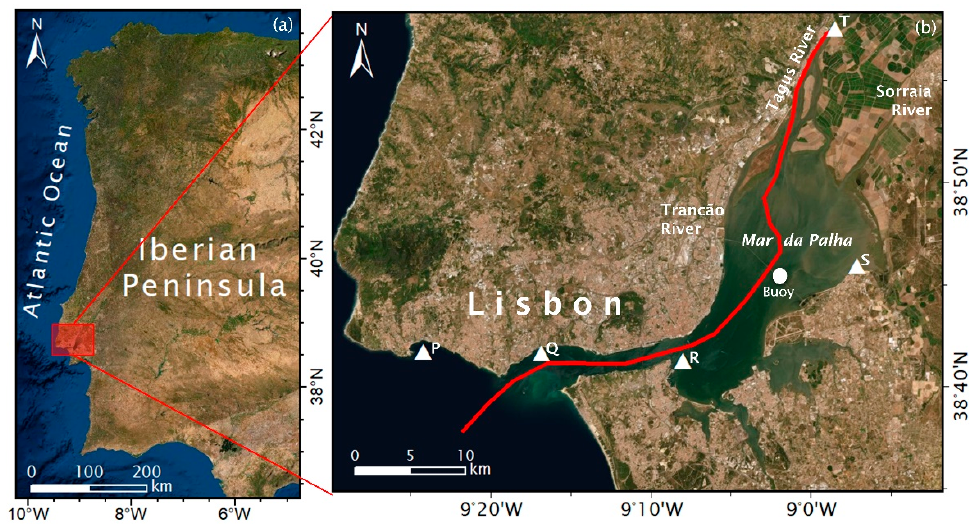
Figure 1. Study area: ( a ) the Iberian Peninsula with the Tagus estuary highlighted in the red rectangle; ( b ) Tagus estuary. The red line corresponds to the longitudinal section along the estuary axis, the white dot to the buoy, and the triangles to the stations (P—Cascais, Q—Paço de Arcos, R—Lisboa, S—Alcochete, and T—Vila Franca de Xira).